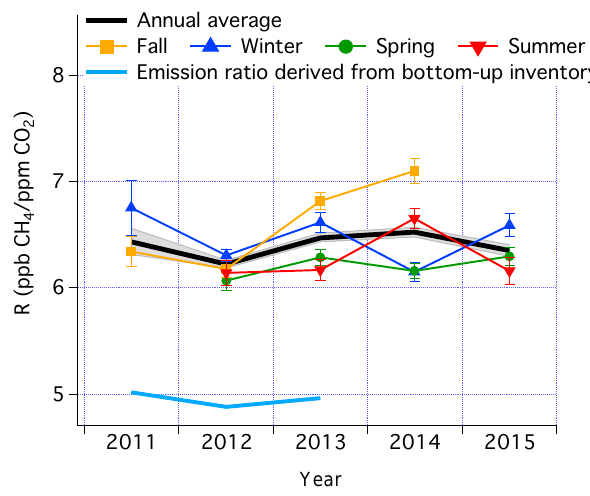
Figure 4. Interannual variability in R (in unit of ppbCH 4 (ppmCO 2 ) − 1 ) in fall (orange), winter (blue), spring (green), and summer (red) from 2011 to 2015. The annual average ratio is shown in black. Also shown are the ± 1 σ uncertainties. Note that data for 2011 and 2015 are derived from partial annual observations (that is, September to December for 2011 and January to August for 2015). The CH 4 :CO 2 ratio based on the population-scaled bottom-up emission inventory from the California Resources Board is shown in light blue (California Air Resources Board,